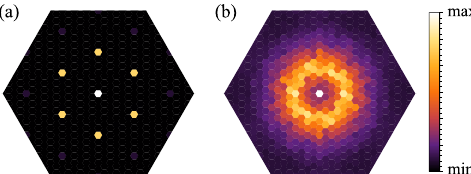
Fig. 7 Equal-time spin correlator. The data is obtained at φ = π /4 and L = 24 in the low-temperature regime T / S 2 = 0.02. a Correlations in the vortex crystal phase at h / S = 0.85 plotted within the fi rst Brillouin zone. In addition to the leading peak at the Γ point, which extends up to Oð 10 3 Þ and re fl ects a strong ferromagnetic correla- tion, the presence of sharp, subleading peaks indicates a periodic vortex arrangement. Color scale shown is in the range [0, 30]. b In the vortex liquid phase at h / S = 0.95, subleading intensity accumu- lates isotropically at a characteristic distance from the Γ point, re fl ecting the typical inter-vortex distance in real space. Color scale shown is in the range [0,